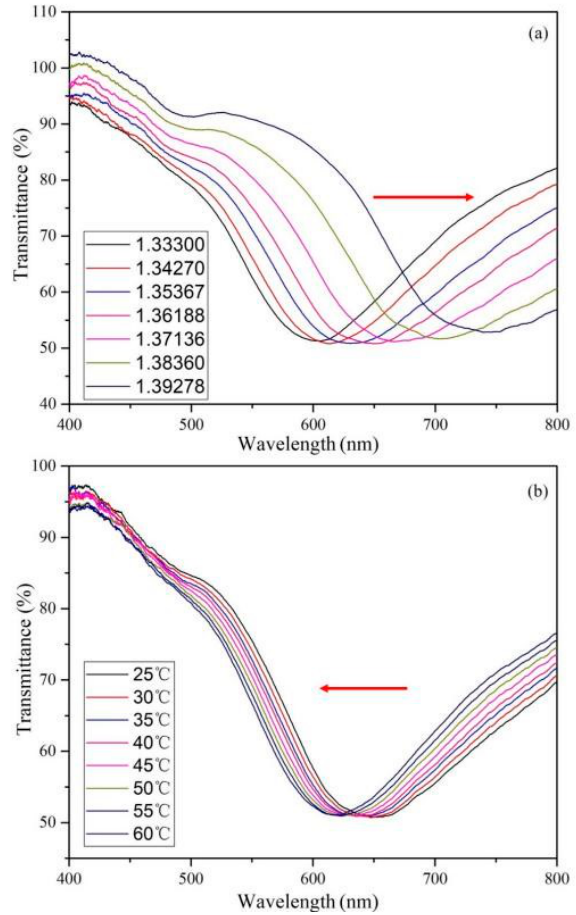
Figure 4. Transmission spectra of the sensing structure at different surrounding refractive indices ( a ) and ambient temperatures ( b ). The thickness of the gold film is 25.753 nm.